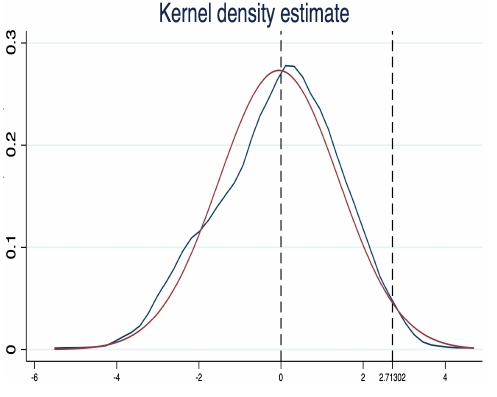
Figure 2. Placebo test. Note: kernel = epanechnikov, bandwidth = 0.3793.